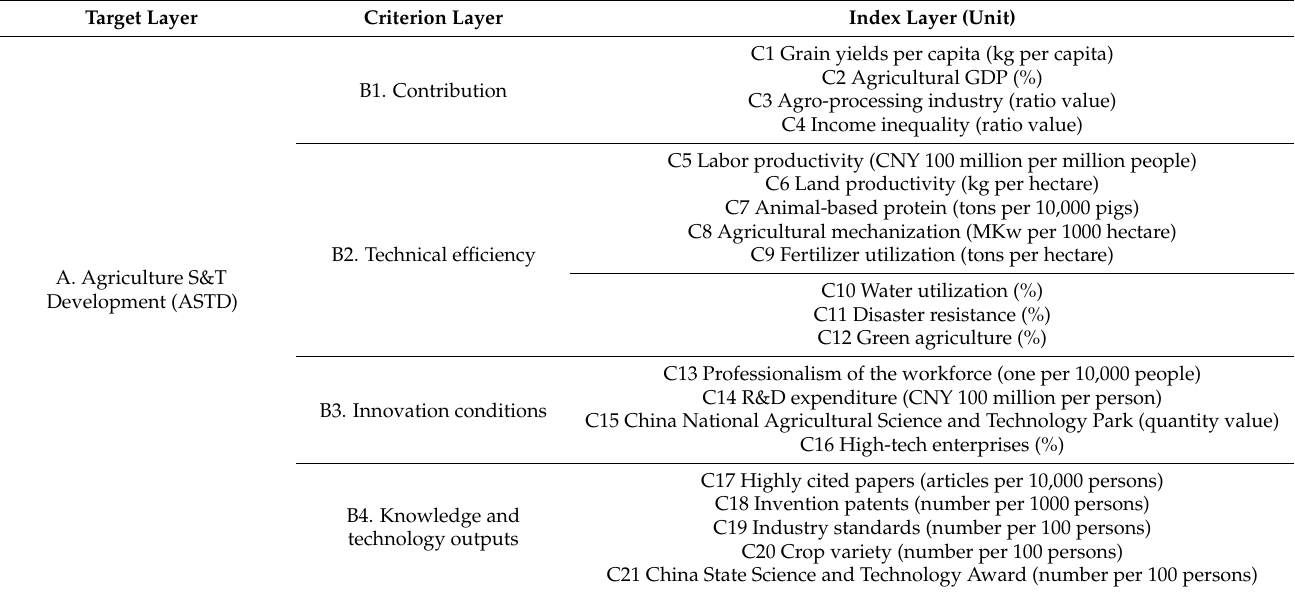
Table 1. The indicator system of